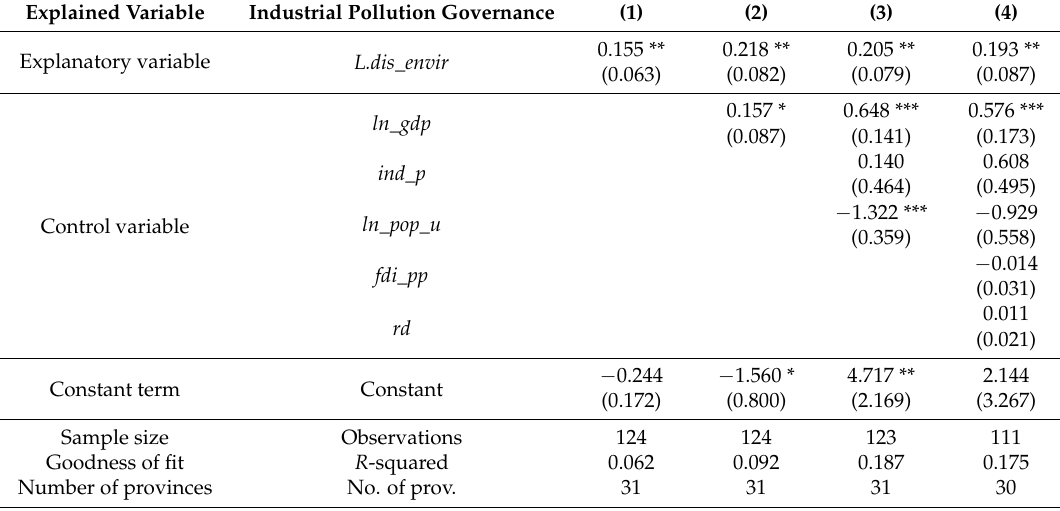
Table 3. Estimation results of the total investment response in industrial pollution governance vis- à -vis public environmental